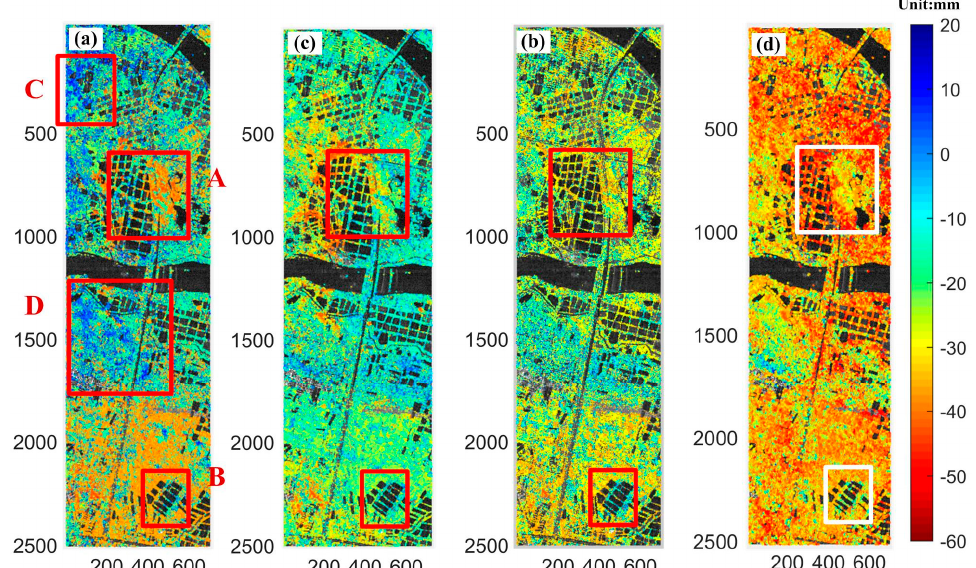
Figure 14. Derived deformation between 2014/06/29-2015/11/27 for 4 models ( a ) MVM; ( b ) PVM; ( c ) SM; ( d ) CM (in slant-range projection).